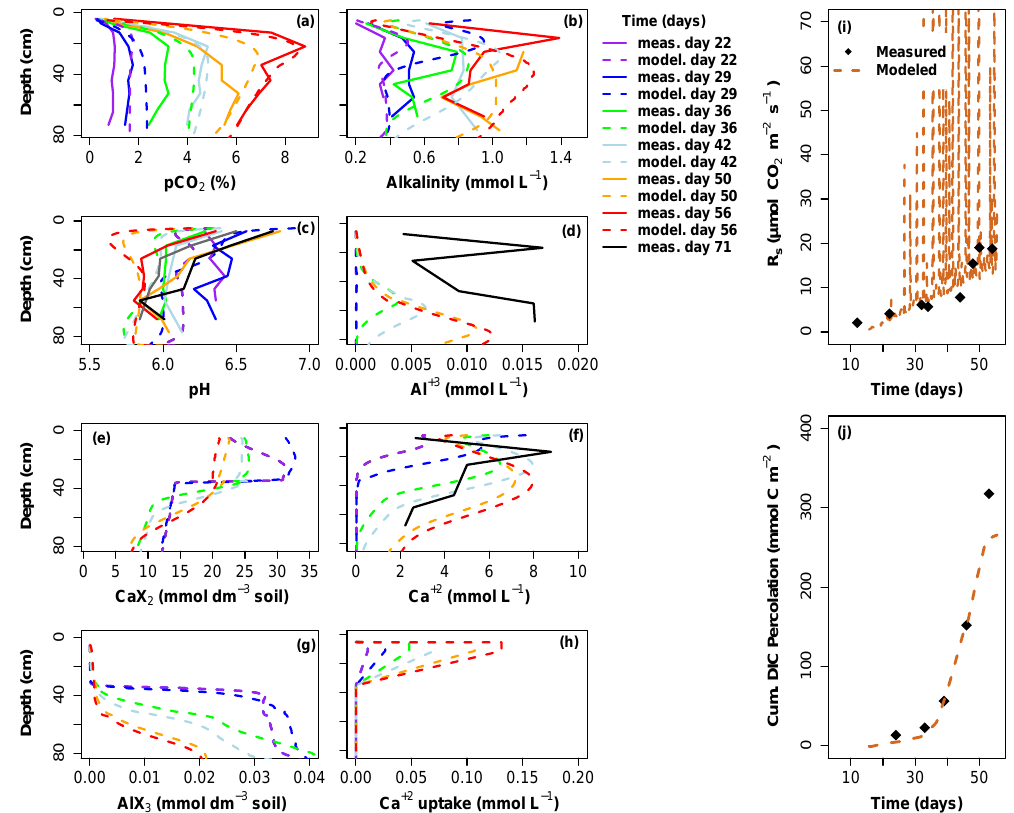
Figure 5. Measured (full lines or dots) and simulated (dashed lines) temporal variation (expressed in days after sowing) of soil air p CO 2 (a) , alkalinity (b) , pH (c) , Al 3 + (d) , CaX 2 (e) , Ca 2 + (f) , AlX 3 (g) , Ca 2 + root uptake (h) , R s (i) and cumulative DIC percolation (j) during barley growth. Geochemical reactions in simulations were described by root nutrient uptake and cation exchange (scenario 1). In (i) small fluctuations in the simulated R s around the baseline arise from diurnal temperature variations. Large fluctuations are numerical noise caused by the fact that the numerical solution does not fully obey the von Neumann stability